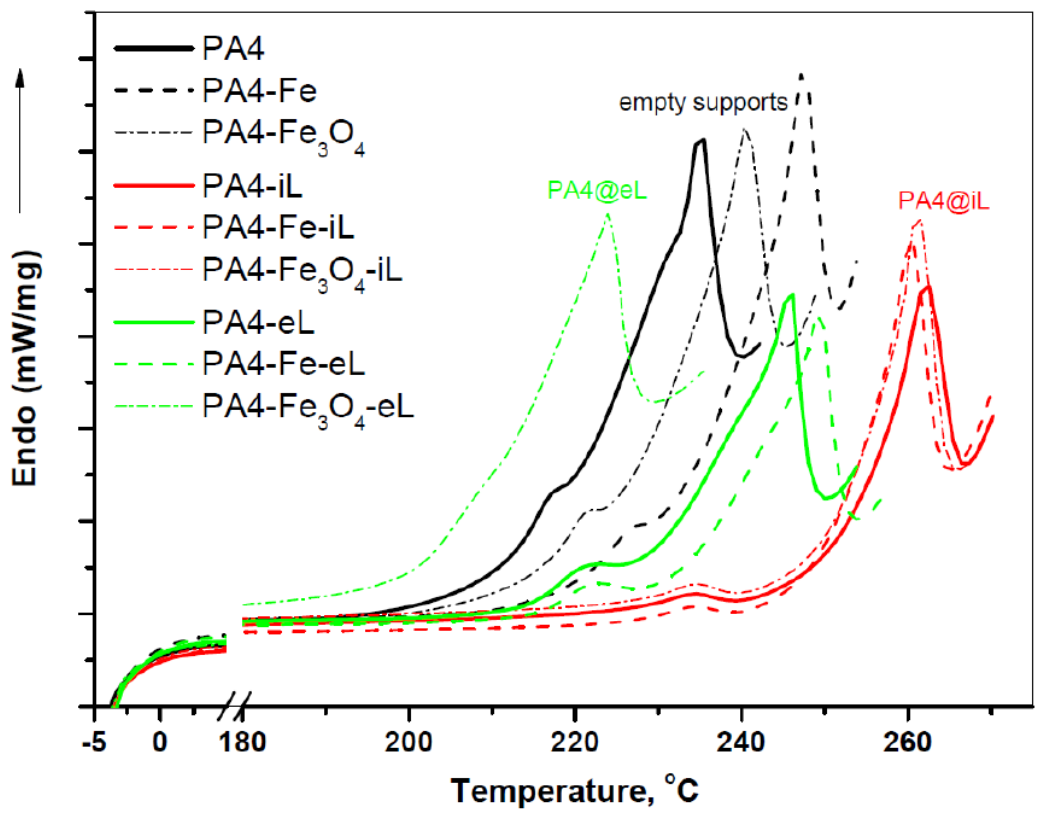
Figure 6. DSC (first scan, heating 10 deg/min) of empty PA4 supports, laccase adsorbed (PA4@iL) and laccase-entrapped (PA4@eL) laccase-entrapped (PA4@eL) conjugates.